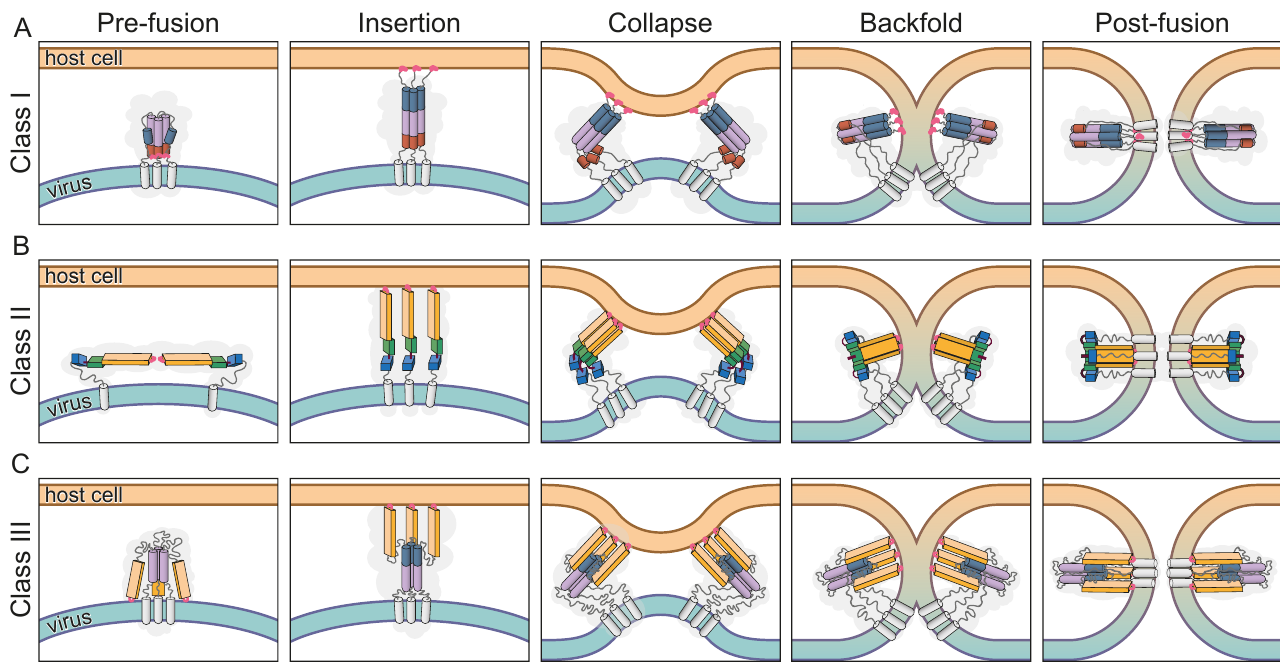
Figure 1. Three classes of viral membrane fusion proteins. Viral fusion class models illustrated by key domains in different states of the fusion process. The fusion proteins go through a number of conformations that drive the membrane fusion from approximation through hemifusion to